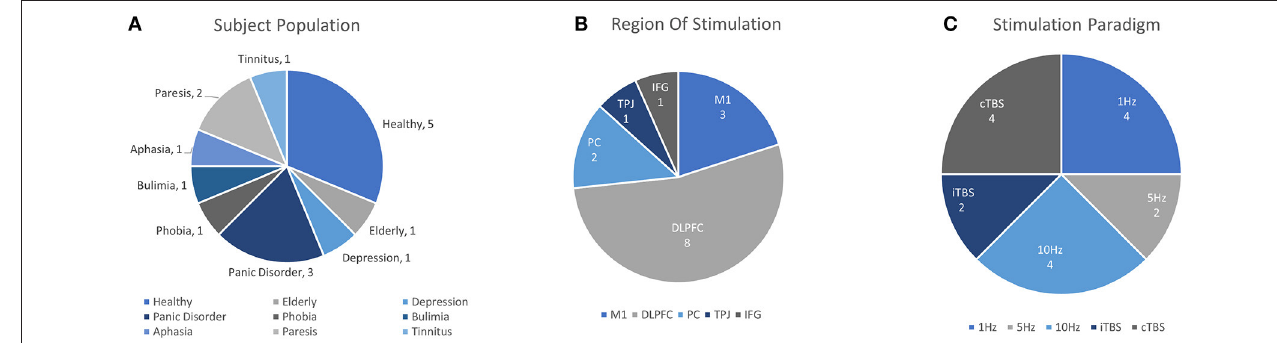
FIGURE 5 | Details of TMS-fNIRS studies applied before or during cognitive Tasks according to (A) Subject Population, (B) Region of Stimulation, and (C) Paradigm of